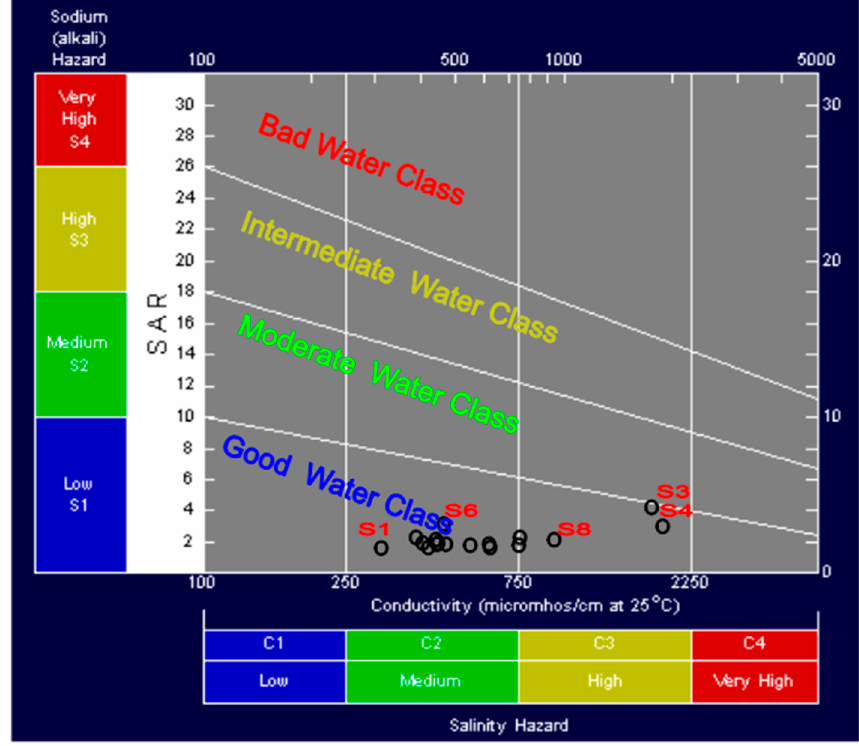
Figure 4. The US Salinity Lab. Staff diagram [35] for Irrigation water classification in the study area. In addition, the spring and well waters data were plotted using the Wilcox diagram [47]. The results indicate that the groundwater of the El-Farafra area is excellent-to-good for irrigation, except for samples no. S3 and S4 which are good to permissible (Figure 5).